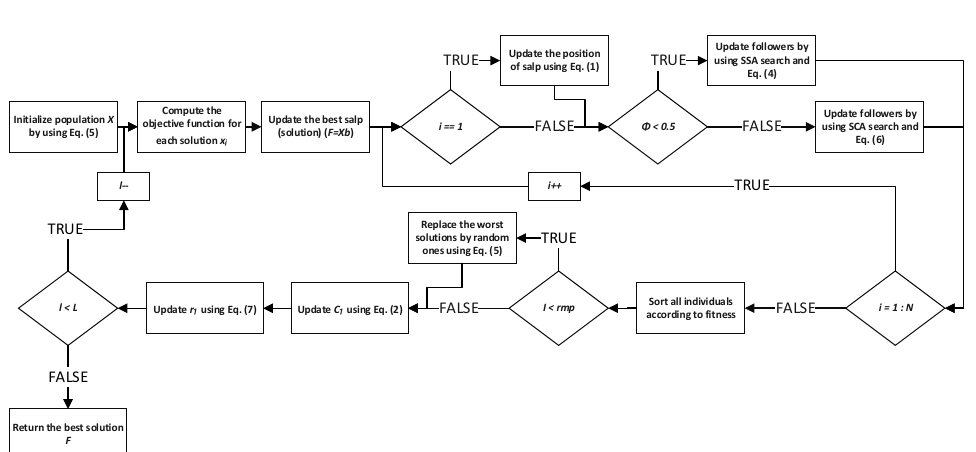
Figure 1. Flowchart of the proposed SSARM-SCA